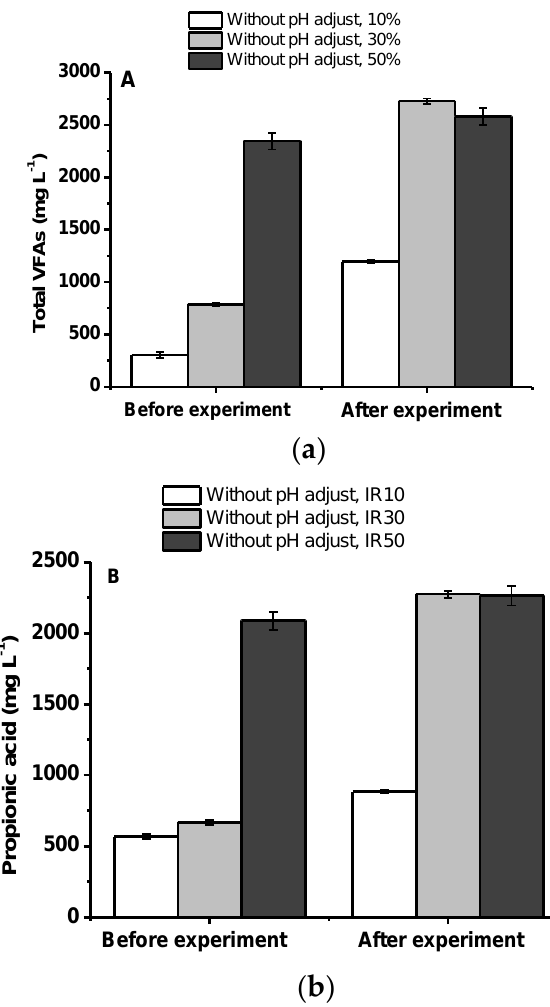
Figure 6. Effect of different IR (without pH adjustment) on total VFAs ( a ) and propionic acid concentrations ( b ). Data indicate mean and its standard deviation of triplicates.